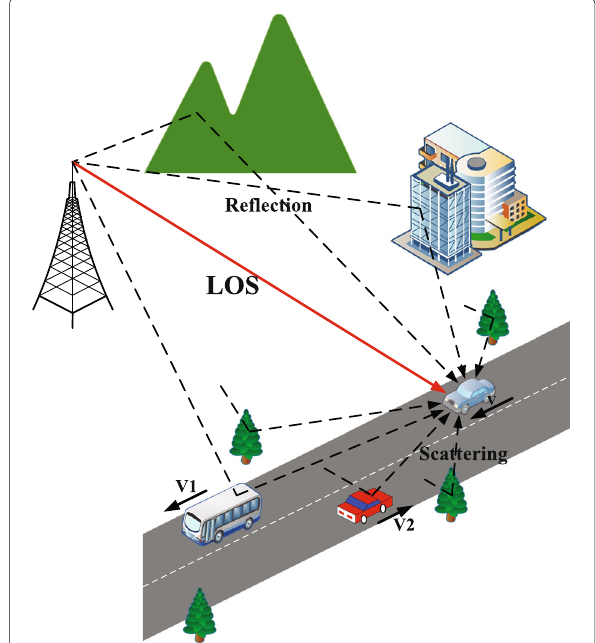
Fig. 1 The schematic diagram of V2V channel scene. This figure illustrates V2V communication scenario